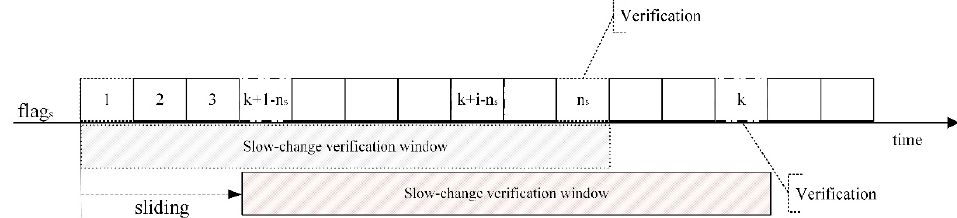
Figure 4. GNSS slow-change verification.